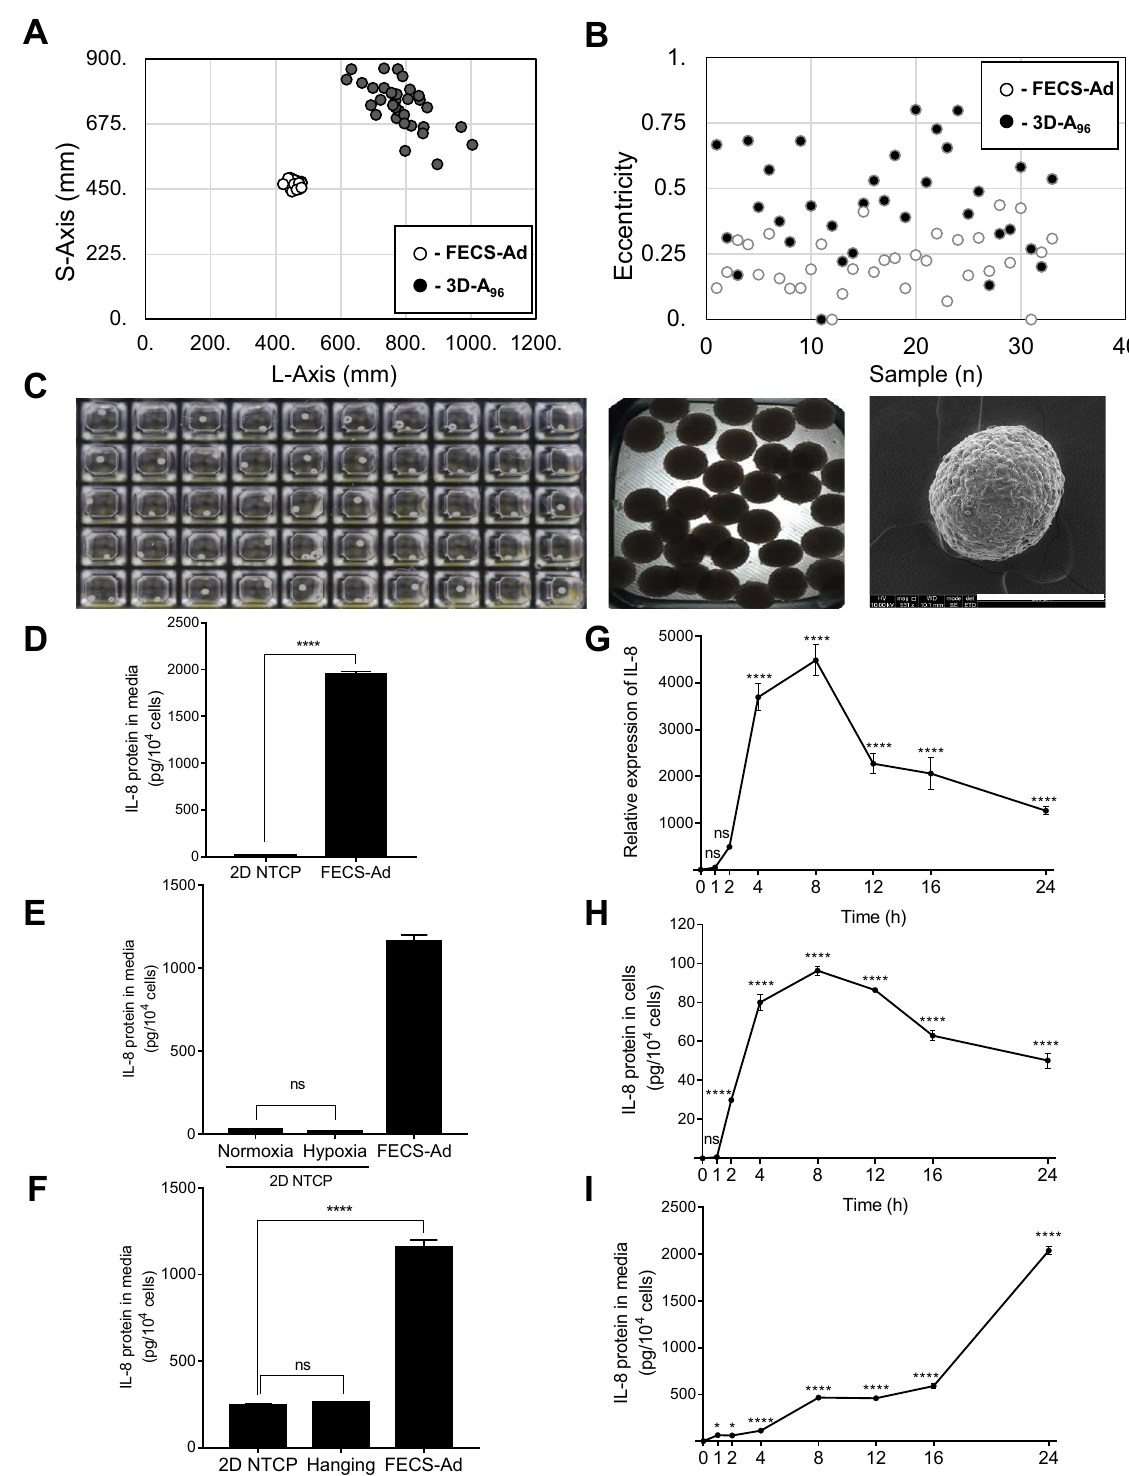
levels of IL-8 in hASCs gradually increased, reached a peak at 8 h, and then steadily decreased during the 24 h period after attachment to the MBP-FGF2 substrate (Fig. 2G, H). IL-8 protein secretion continuously increased over 24 h, accumulating in the media (Fig. 2I). These results indicated that increased IL-8 expression during the formation of FECS-Ad was mainly